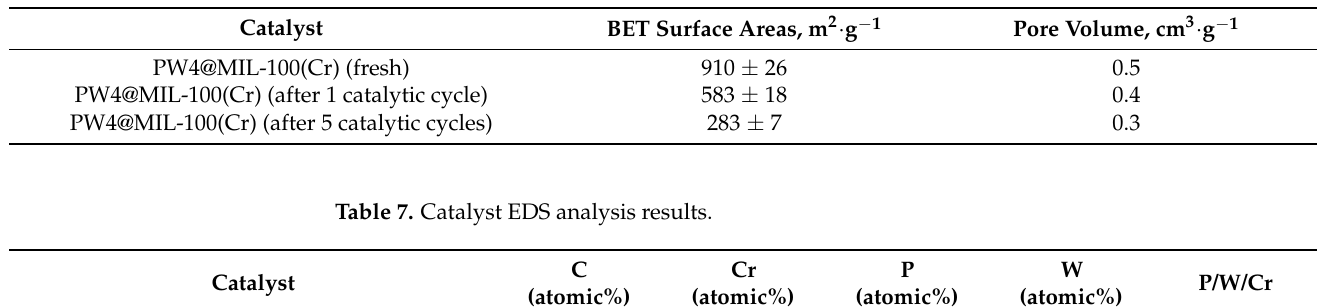
Table 6. Textural properties of fresh and spent PW4@MIL-100(Cr) catalysts.